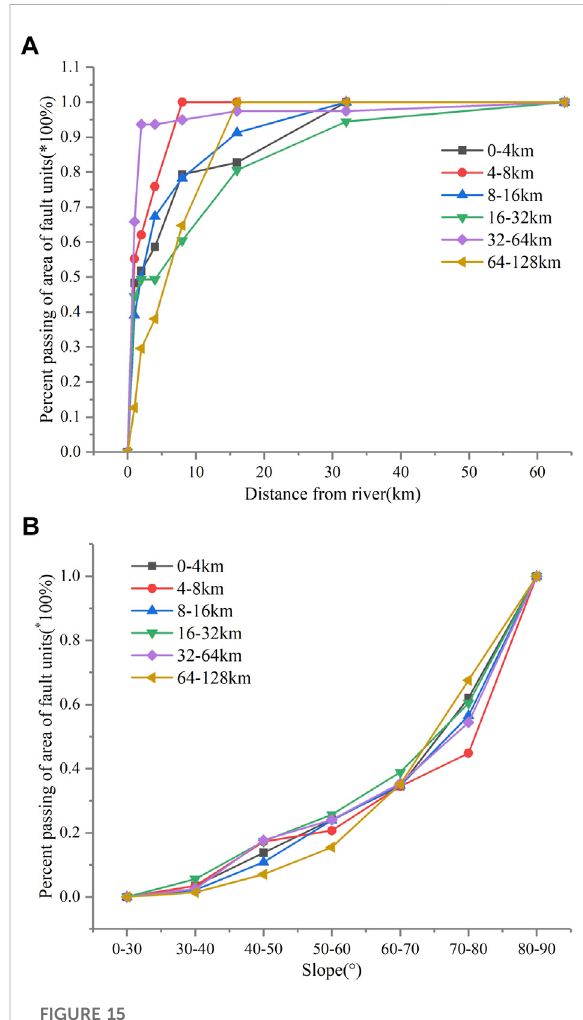
FIGURE 15 Percent passing area of six units of (A) distance from fault system vs distance from river and (B) slope